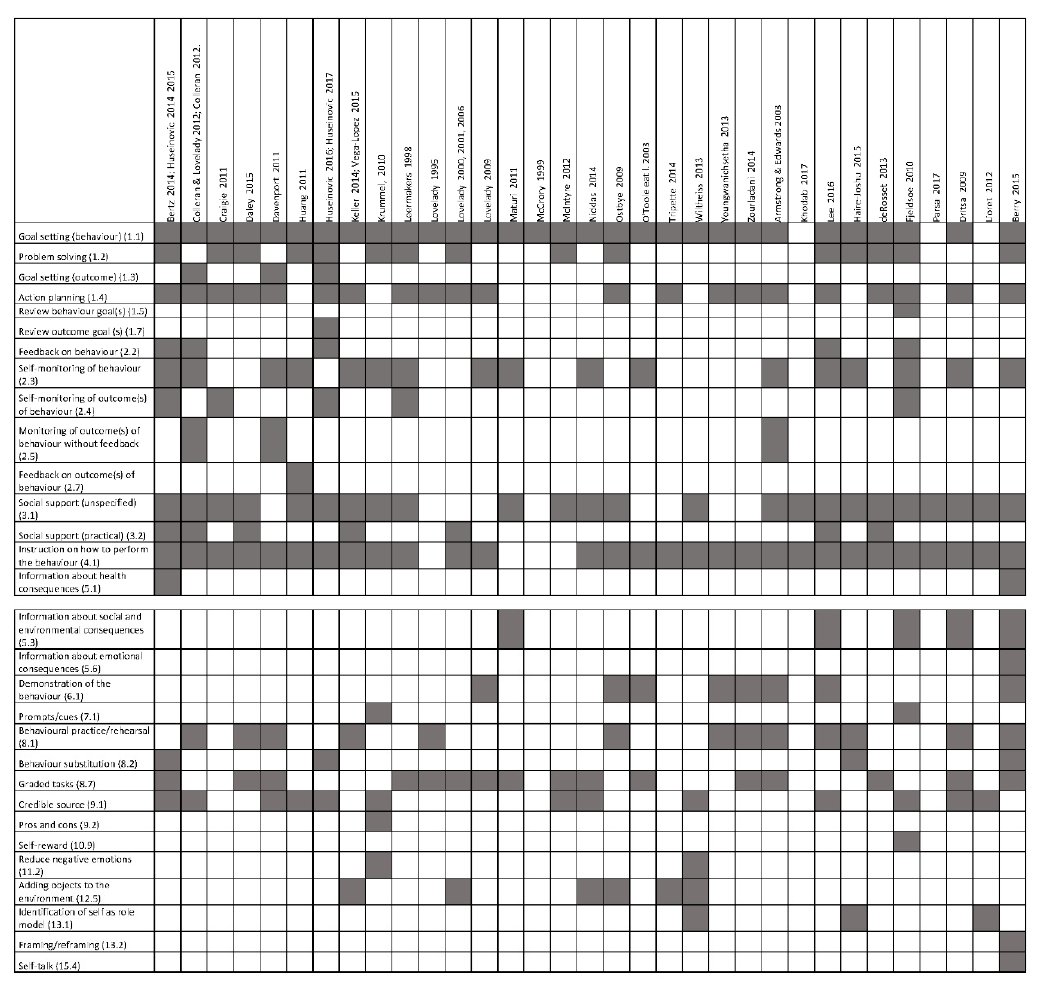
Figure 2. Behavioural strategies in lifestyle interventions in postpartum women. Table 2. Univariate meta-regression for energy intake in lifestyle interventions for postpartum women by behavioural strategies (k = 12).